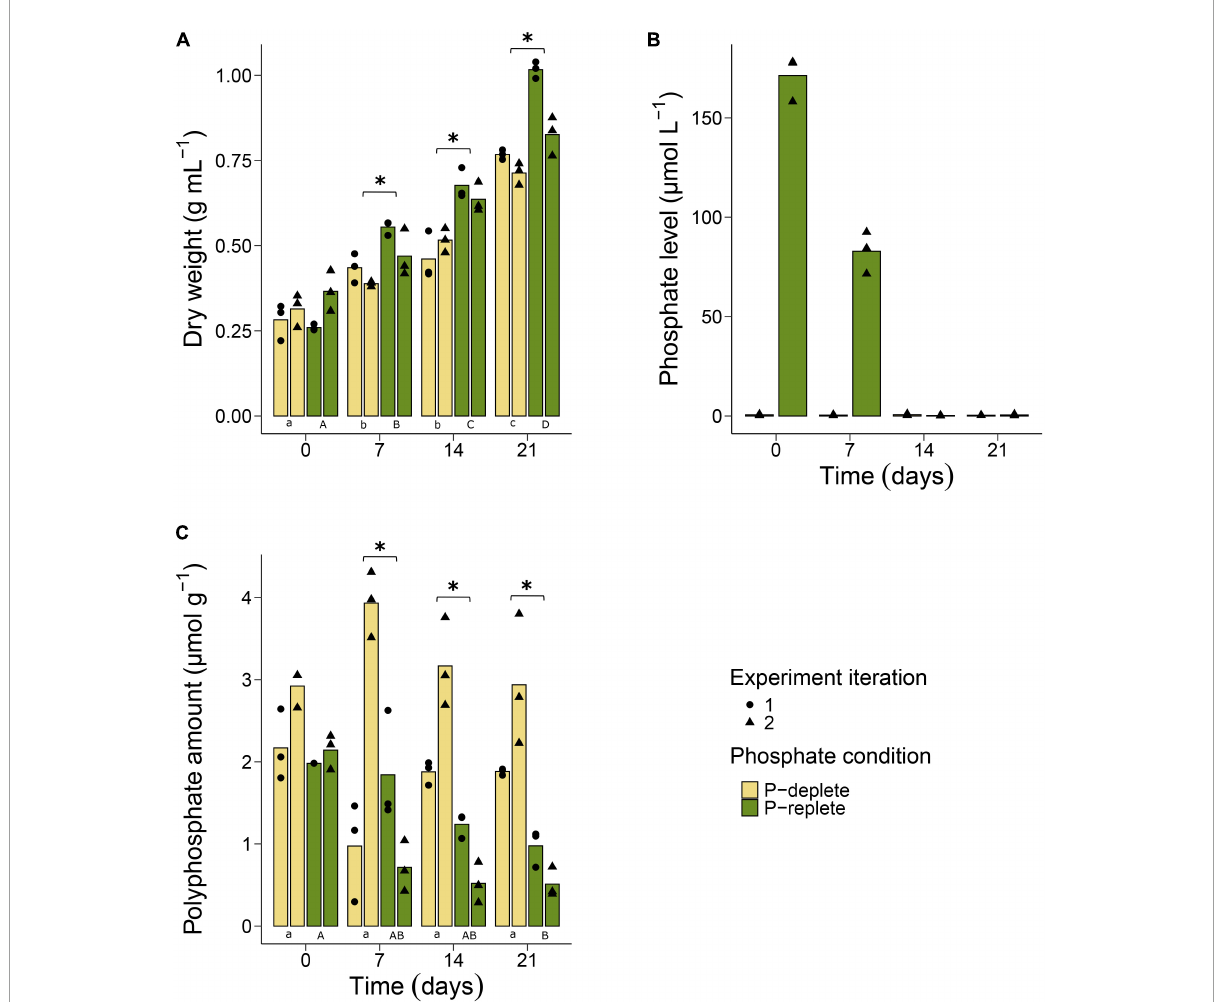
FIGURE1 Physiological and biochemical assessment of Nodularia spumigena CCY9414 under P-replete (+P) and P-deplete (–P) conditions. Growth expressed as increase in dry weight (A) . O -phosphate (PO 43 − ) concentration in the cultivation media during the second experiment iteration (B) . Accumulation of polyphosphates in cells of N. spumigena (C) . Bars represent means of individual measurements shown as single points. Asterisks indicate significant differences between the P-replete and the P-deplete cultures at each sampling time point. Significant differences between sampling time points are indicated by different lower-case (P-deplete) and upper-case (P-replete) letters. The results of the statistical tests can be found in the Supplementary Tables 1 , 2 .